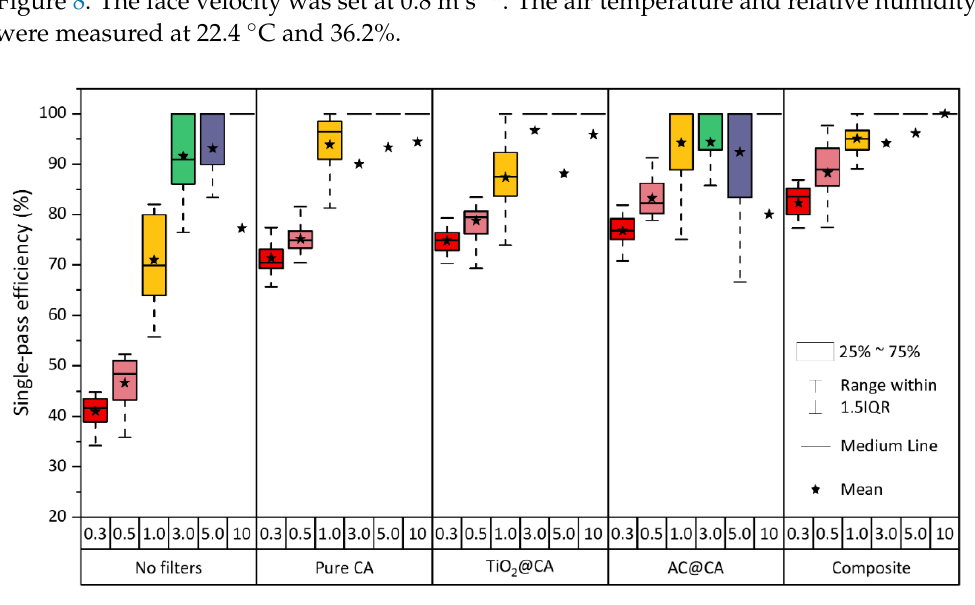
Figure 8. Particle filtration efficiency for the different filters per particle size.